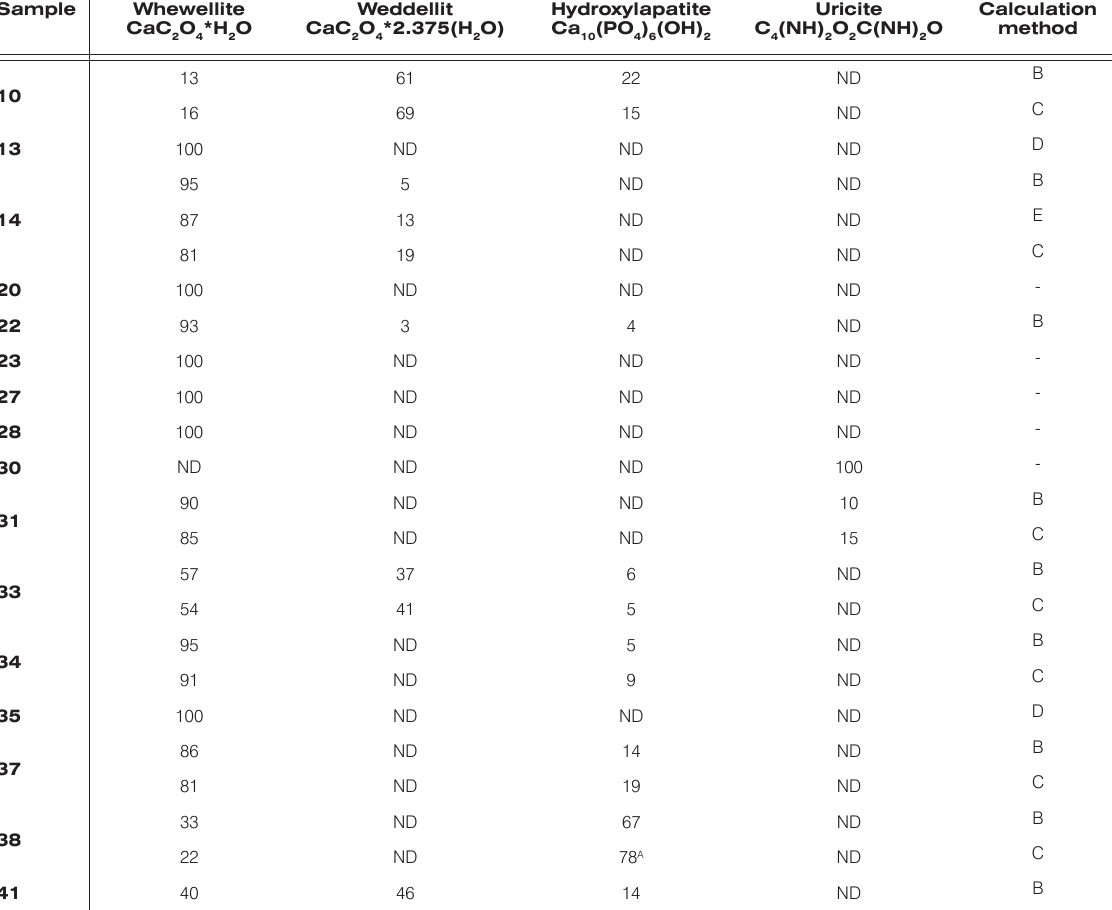
Table 3. Results of quantitative PXRD analysis of the urinary stones (mass%) (ND: non detectable).